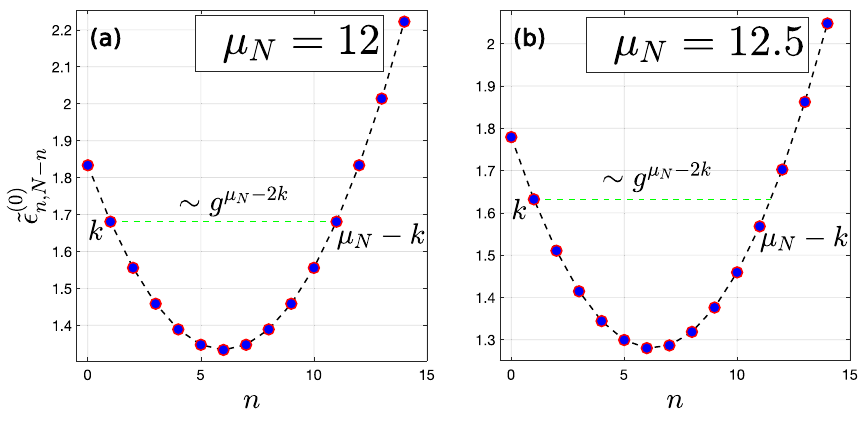
( 0 ) N ) 2 (with ε denoting the ε ( 0 ) n , N n = (α 1 + α 2 )ε n , N n /(� + α 2 ˜ 0 , N 1.1 , and ( a ) µ 14 , α 2 /α 1 − − = = =